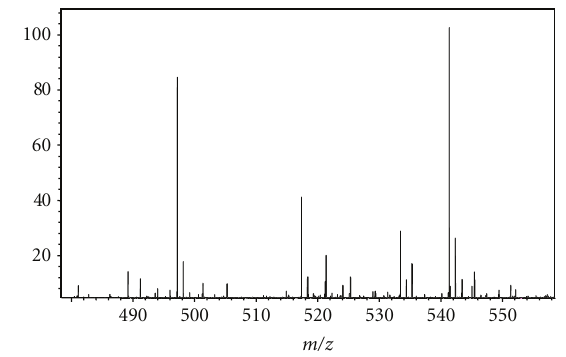
Figure 8: Inset of PS mass spectrum for urine specimen from 44-year-old volunteer being treated with prescription vitamin D supplement over m/z